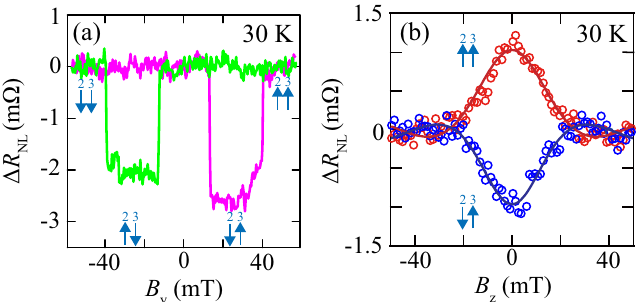
Figure 3. Four-terminal nonlocal ( a ) magnetoresistance curve and ( b ) Hanle-effect curves for the parallel and antiparallel magnetization configurations at 30 K. The solid curves in ( b ) indicate the results fitted to Equation (2) in Ref.